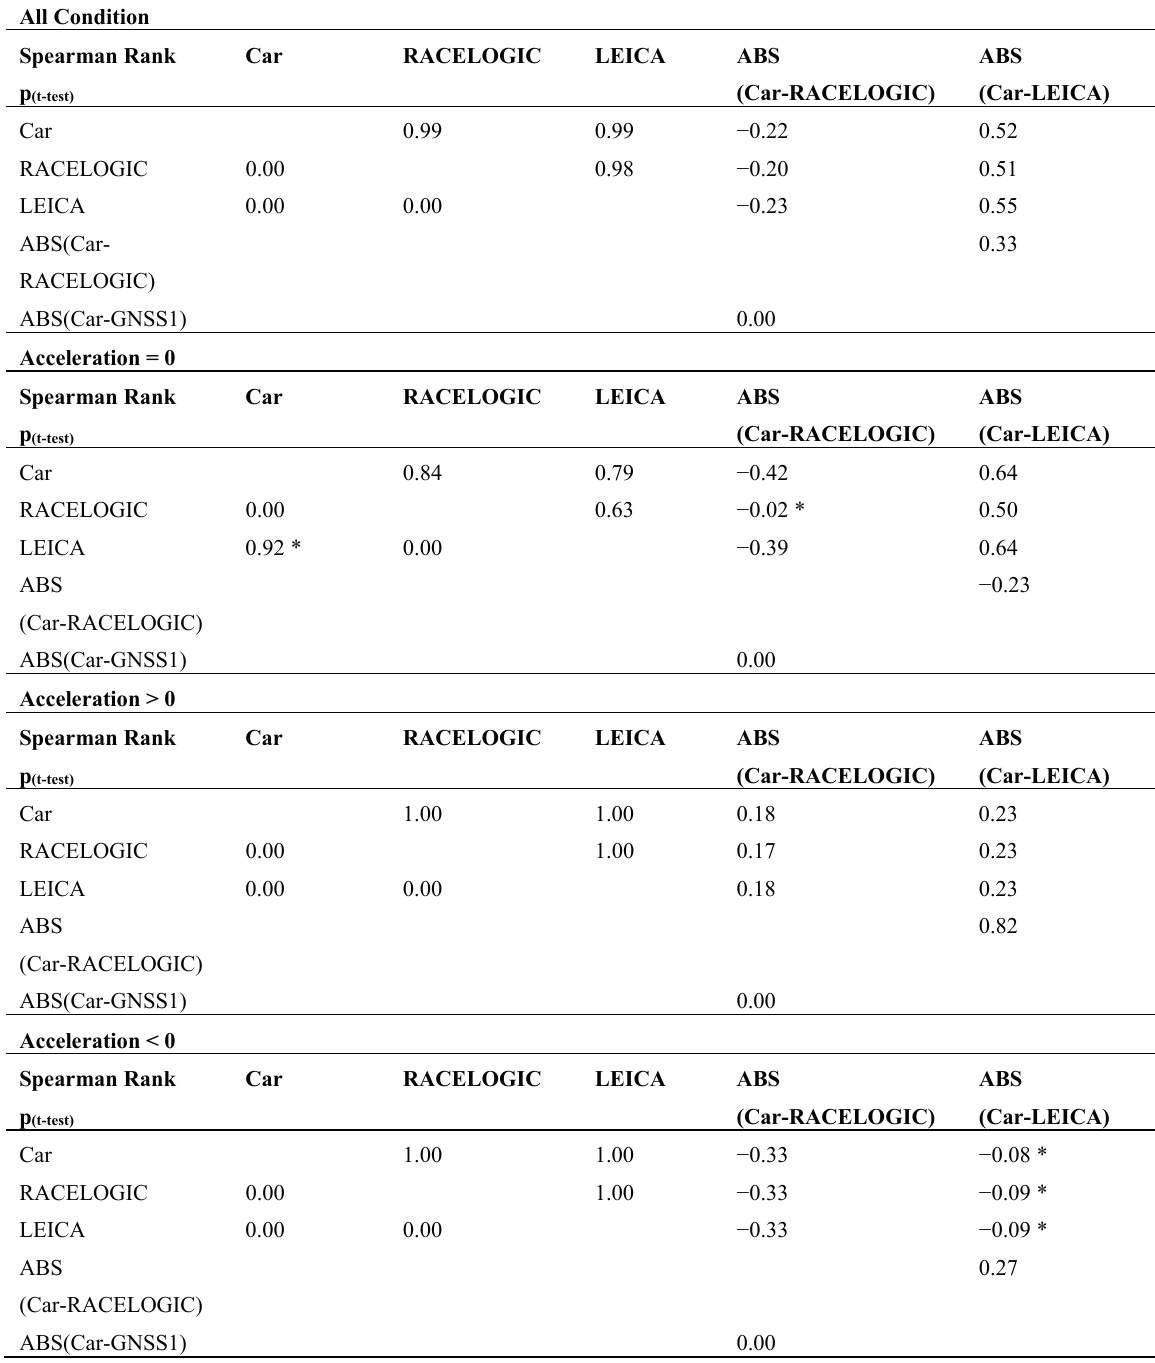
Table 3. Significance of pairwise sample t-test (lower triangle) and Spearman rank correlations (upper triangle) between vehicle speedometer (Car), Racelogic and